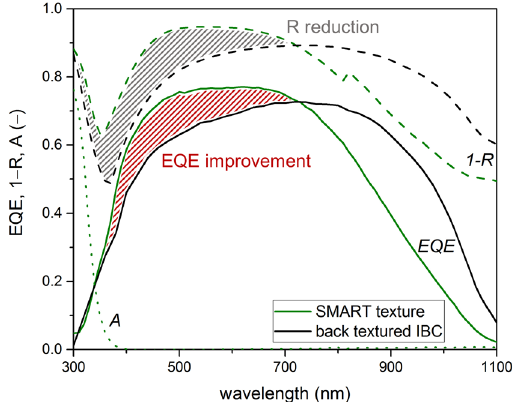
Figure 7. Optoelectronic characterization of the SMART texture (green) and state-of-the-art back textured IBC cell (black), measured by external quantum efficiency (EQE, solid) and 1-reflectance (1 − R , dashed). The dotted curve shows the parasitic absorption in the SMART texture ( A ,